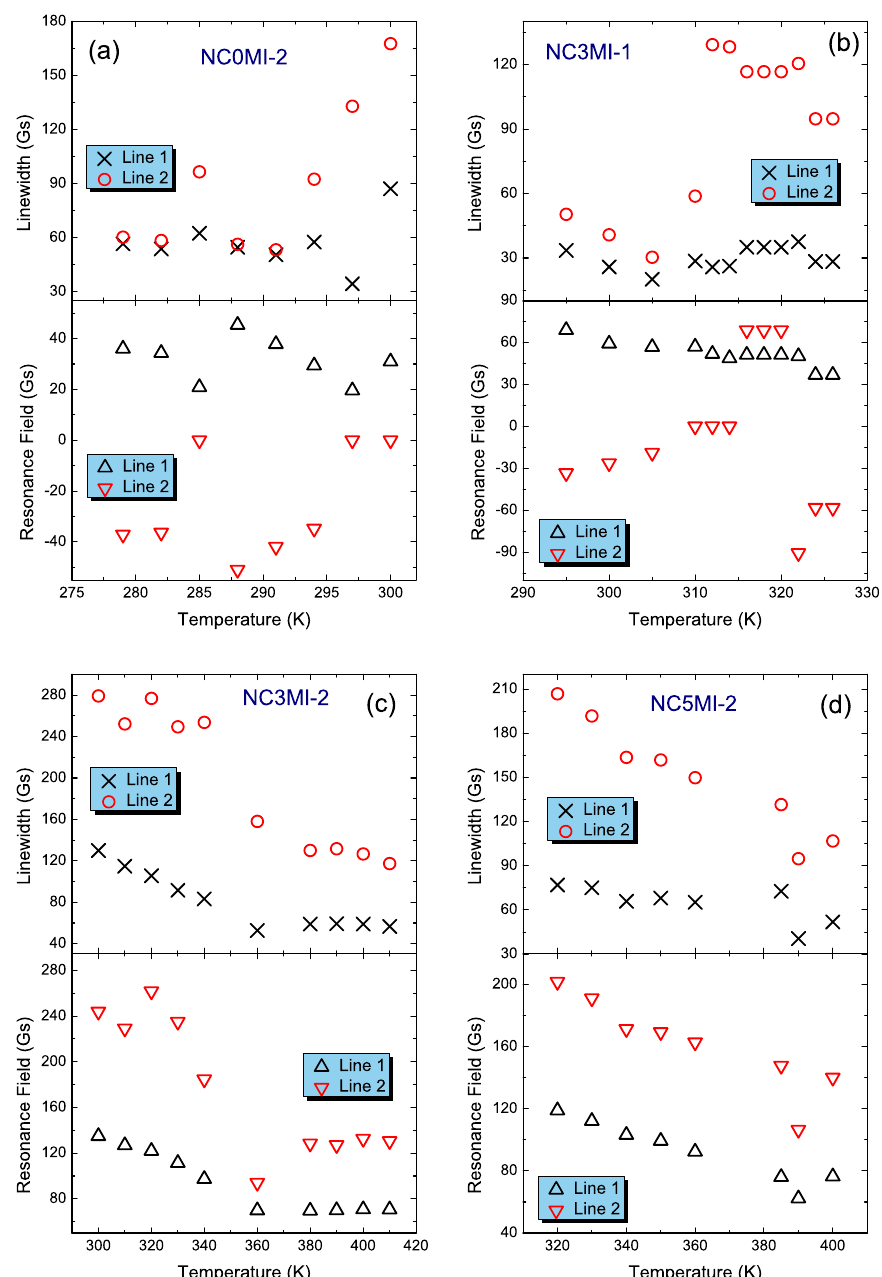
Figure 5. Linewidth and resonance field as a function of the temperature for two fitted lines of in situ Ni 47 Co 3 Mn 35.5 In 14.5 ( b ) and annealed ribbons: Ni 50 Mn 35.5 In 14.5 ( a ), Ni 47 Co 3 Mn 35.5 In 14.5 ( c ) and Ni 45 Co 5 Mn 35.5 In 14.5 ( d